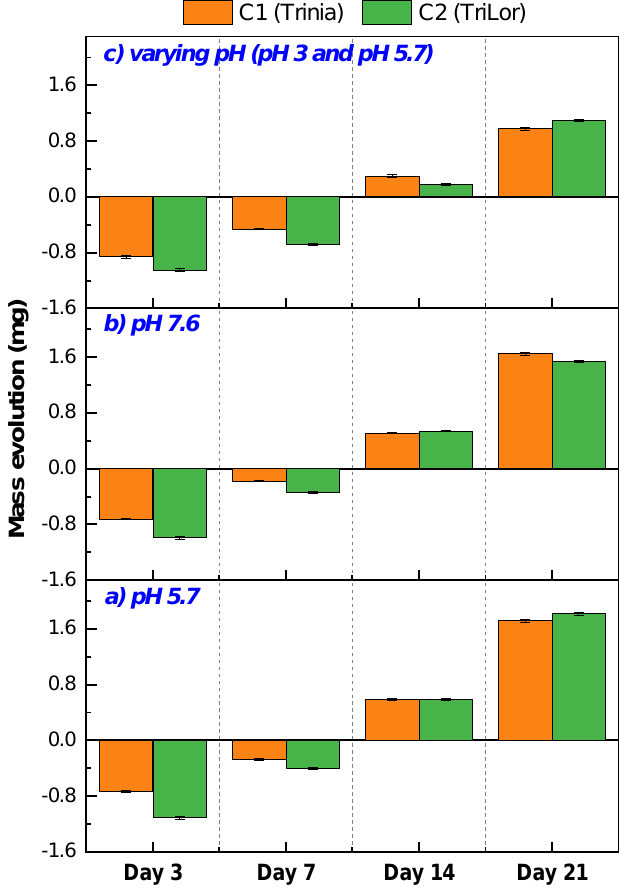
Figure 5. Evolution of the samples mass in artificial saliva: ( a ) of pH 5.7; ( b ) of pH 7.6; ( c ) of varied pH (5.7 – 3).